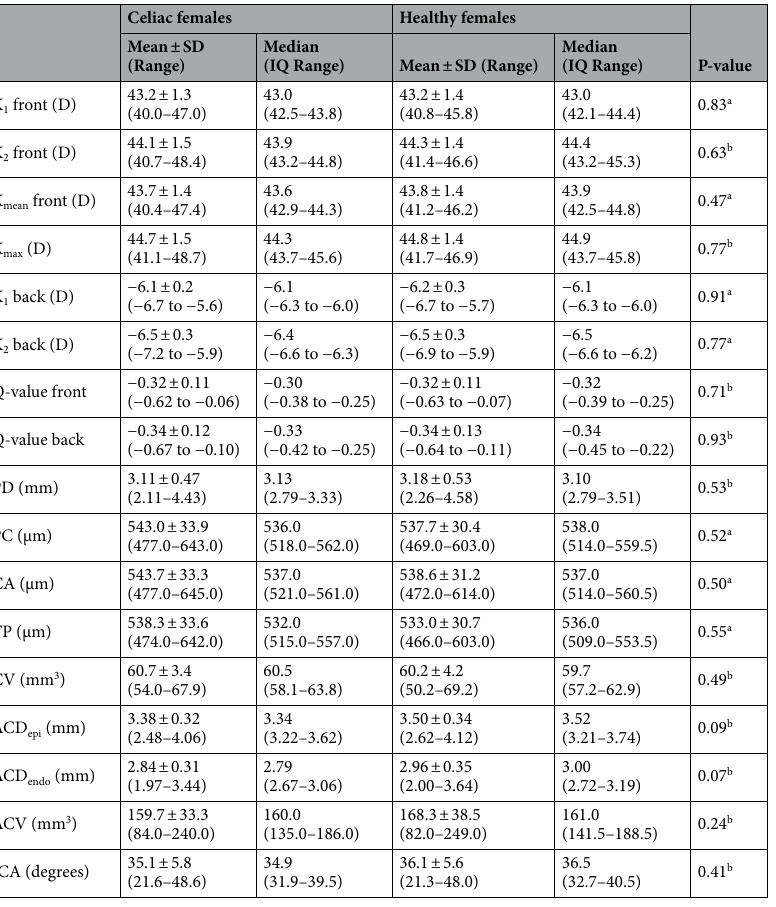
Table 6. Tomographic parameters assessed with Pentacam HR in the two female groups. a Mann Whitney U test. b Student t-test unpaired. SD: Standard Deviation; IQ: Interquartile; D: Diopter; PD: Pupil Diameter; PC: Pupil Center; CA: Corneal Apex; TP: Thinnest Point; CV: Corneal Volume; ACD epi : Anterior Chamber Depth from epithelium; ACD endo : Anterior Chamber Depth from endothelium; ACV: Anterior Chamber Volume; ICA: Iridocorneal